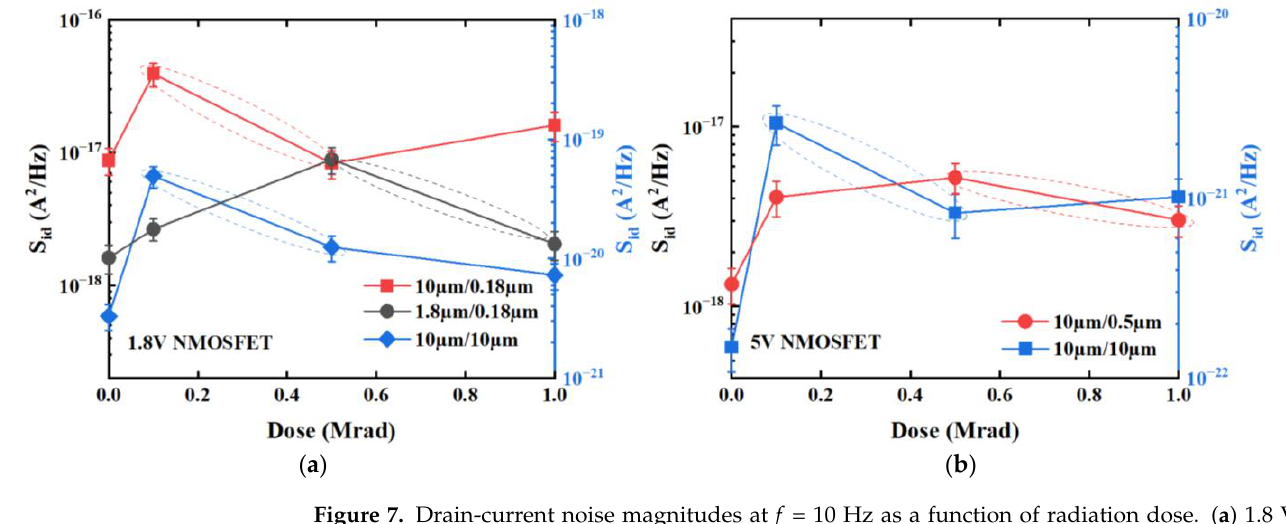
Figure 7. Drain-current noise magnitudes at f = 10 Hz as a function of radiation dose. ( a ) 1.8V NMOSFETs for geometries: W / L = 10 μm/10 μm, 10 μm/0.18 μm and 1.8 μm/0.18 μm, and ( b ) 5V NMOSFETs for geometries: W / L = 10 μm/10 μm and 10 μm/0.5 μm. All devices were irradiated up to 1 Mrad(Si) in the “on” bias condition. Noise measurements were carried out when V gs − V th = 0.3 V and V ds = 0.1 V.